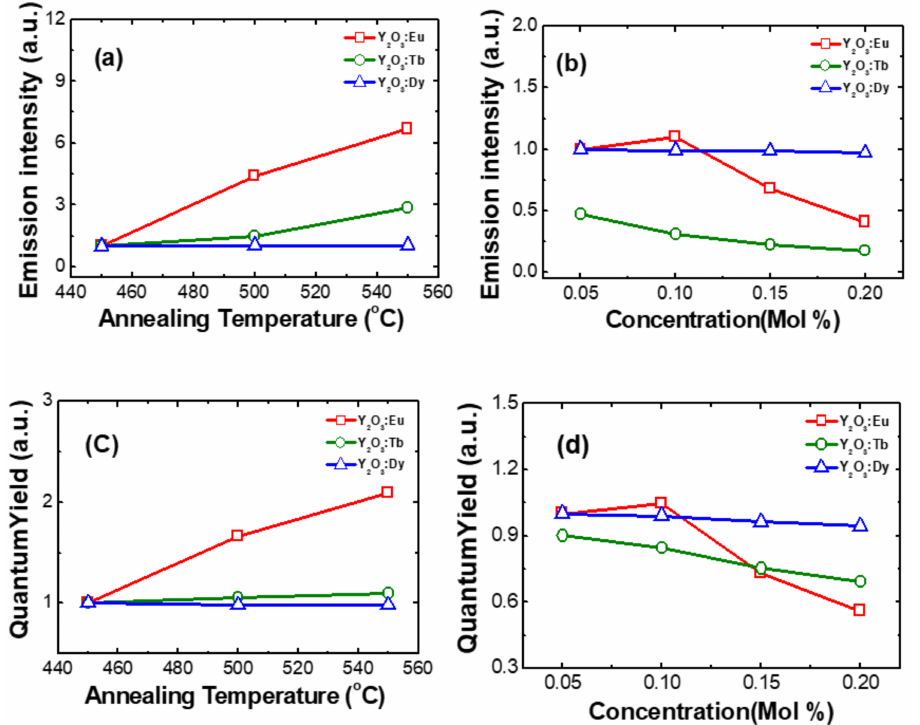
Figure 5. ( a ) Variation of emission intensity with annealing temperature at 450, 500, 550 ◦ C, ( b ) Varia- tion of emission intensity with concentration at 0.05, 0.10, 0.15, 0.20 mMol%, ( c ) Variation of quantum yield with annealing temperature at 450, 500, 550 ◦ C, and ( d ) Variation of quantum yield with concentration at 0.05, 0.10, 0.15, 0.20 mMol% in RE 3+ (Eu, Tb, Dy)-doped